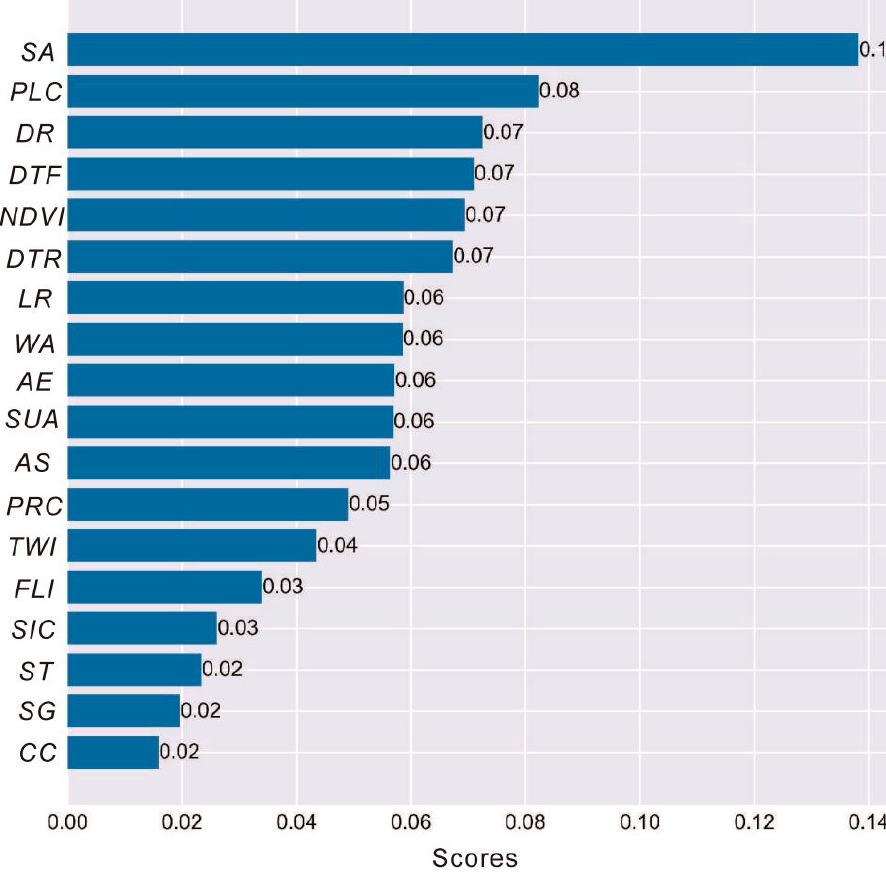
Figure 12. Calculated importance of the parameters.